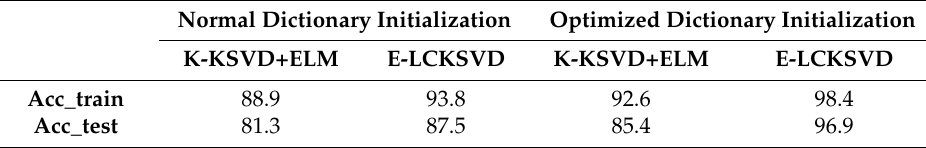
Table 7. The classification accuracy of different dictionary initialization methods